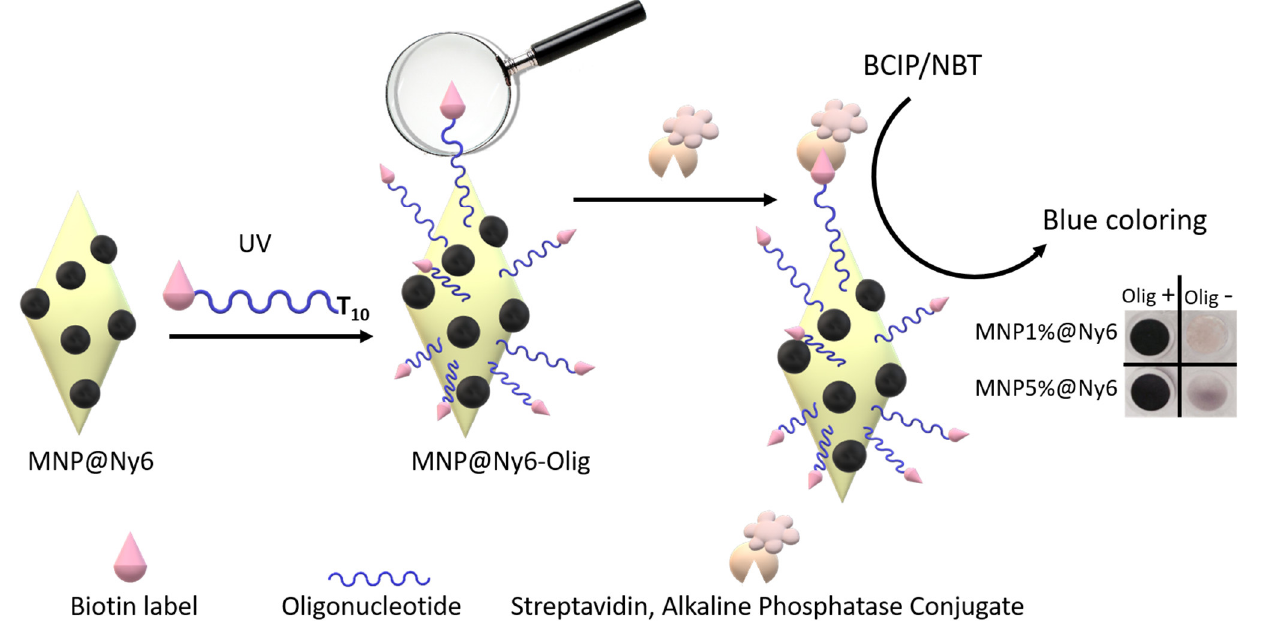
Figure 4. The oligonucleotide UV-immobilization efficiency studies use colorimetric assay for biotin label detection. Biotin label interacts with streptavidin, alkaline phosphatase conjugate, and BCIP/NBT chromogenic substrates, yielding intensive dark blue color. BCIP—5-bromo-4-chloro-3- indolyl phosphate, NBT—nitro blue tetrazolium.